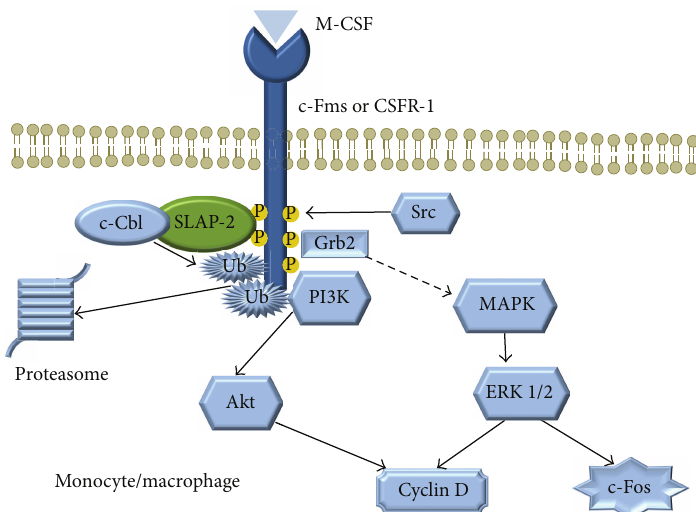
Figure 5: The role of SLAP-2 in